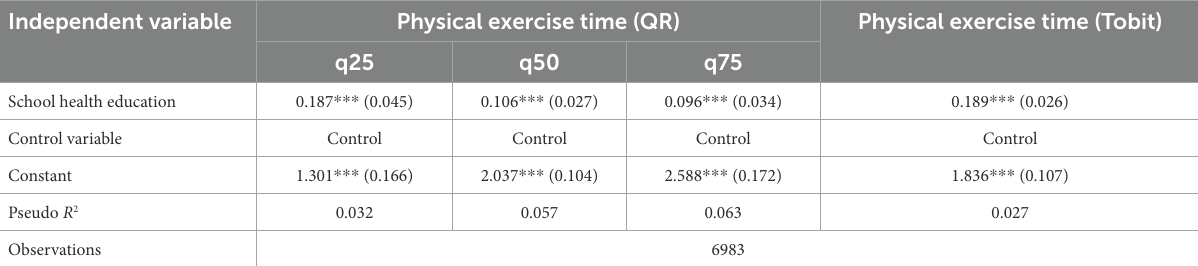
TABLE 4 Robustness test: quantile regression, merge regression.